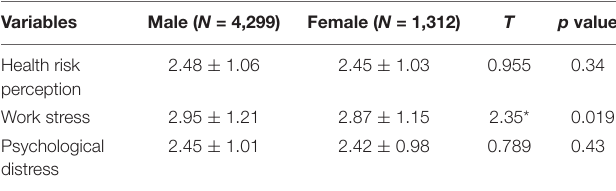
TABLE 2 | Comparison of the average level of health risk perception, work stress, and psychological distress between different